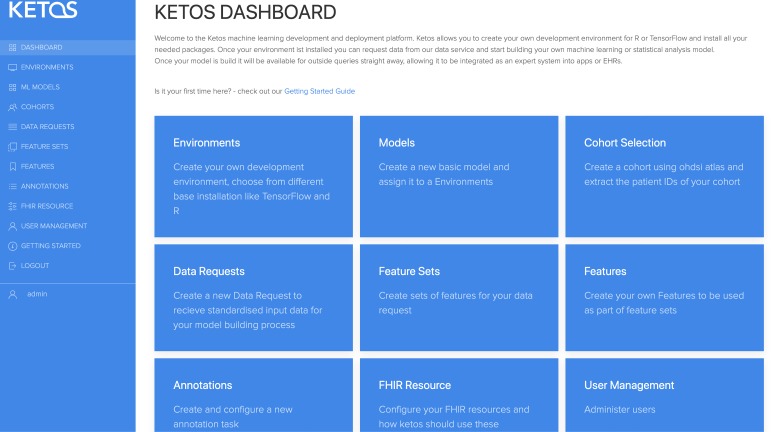
KETOS GUI Dashboard.